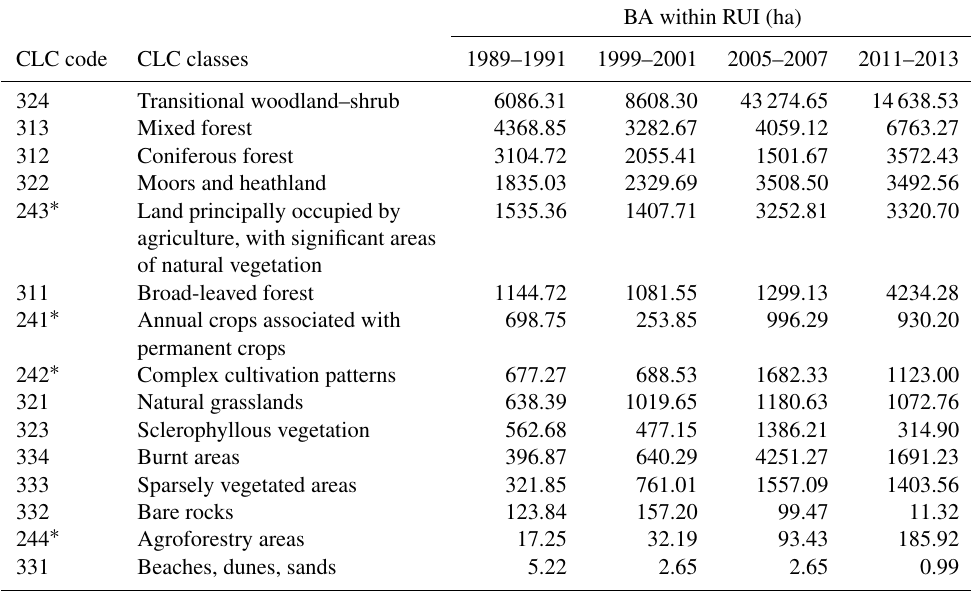
Table 2. Classes of land use, as defined by the third-level hierarchy of the CORINE Land Cover (CLC), affected by wildfires expressed in terms of burnt area (BA) within the rural–urban interface (RUI) during three investigated periods.